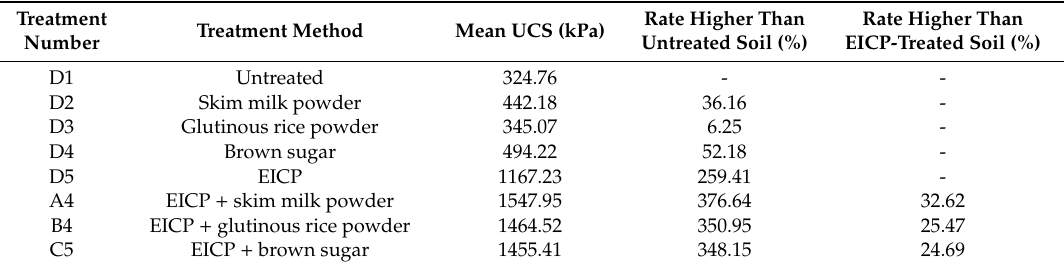
Figure 6. Unconfined compression strength for soil treated by different methods. Table 4. Mean UCS and the strength increasing rate of the proposed methods.